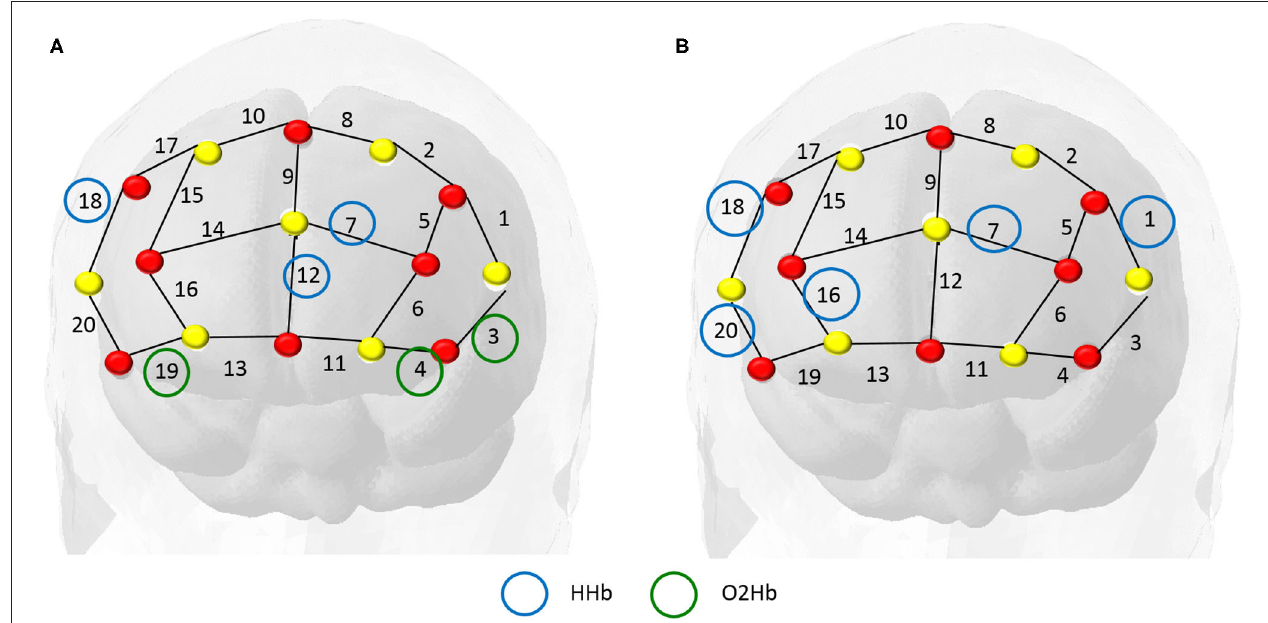
FIGURE 8 | In these maps, the red dots represent the sources and the yellow dots the detectors. Panel (A) refers to the GLMNET Model output and strongly indicates channel 18 HHb (F4-F6) and channel 4 O2Hb (AF7-FP1). Panel (B) refers to the Random Forest Model output and indicates greater relevance for channel 18 HHb (F4-F6) and channel 7 HHb (AF3- AFz). The channel 18 region is the dorsolateral prefrontal region, associated with attention and working memory.